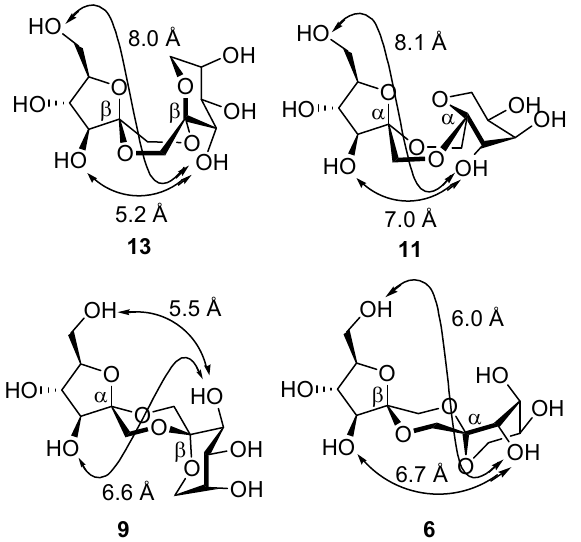
Figure 13 . Conformations of the different type II DFAs and their O-3 − O-3’ and O-6 − O-3’ interatomic